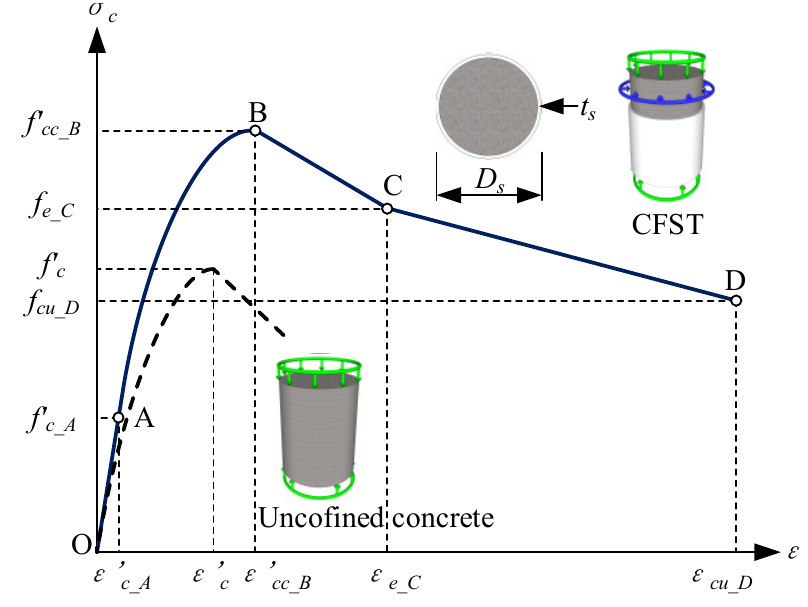
Figure 2. Stress–strain model for the CFST.